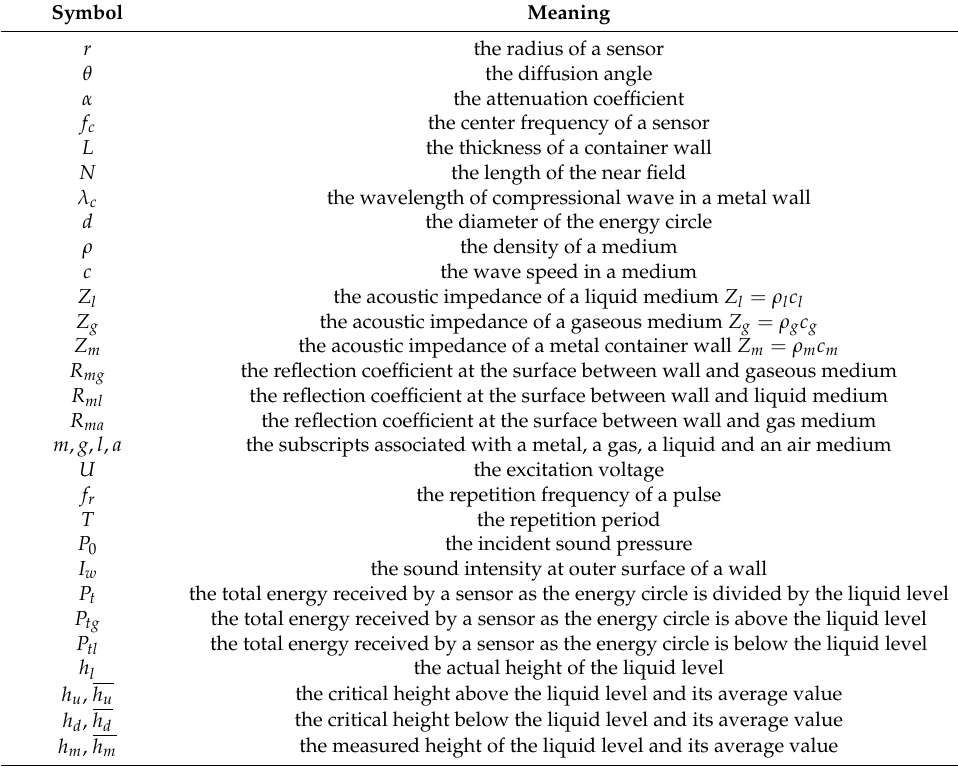
Table 1. The symbols used in this paper and their meanings. Symbol